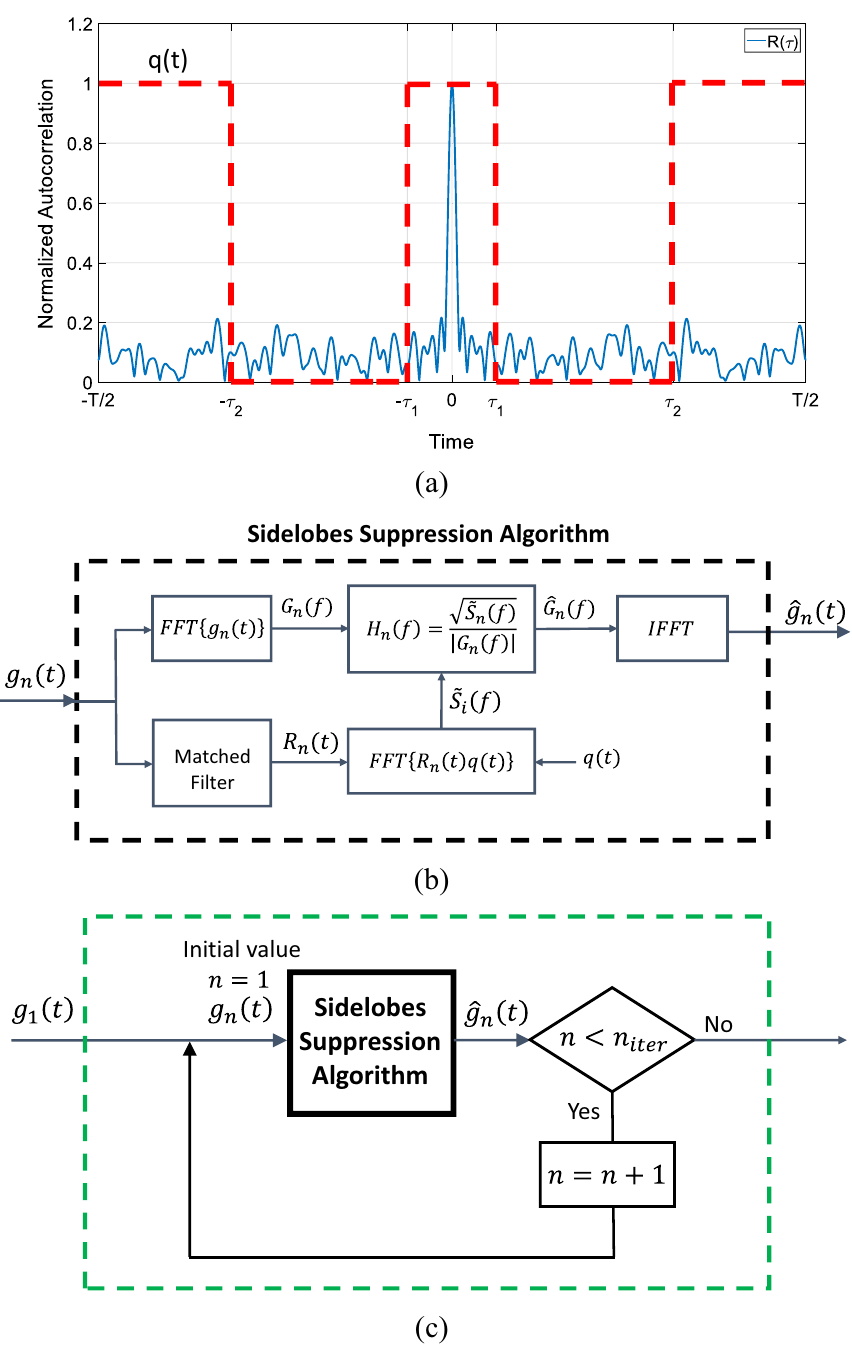
Fig. 17 a The sidelobes suppression interval ( τ 1 , τ 2 ) as defined by q ( t ). b The inverse filtering method to suppress the sidelobes in a specific range zone. c The iterative algorithm to improve the suppression of